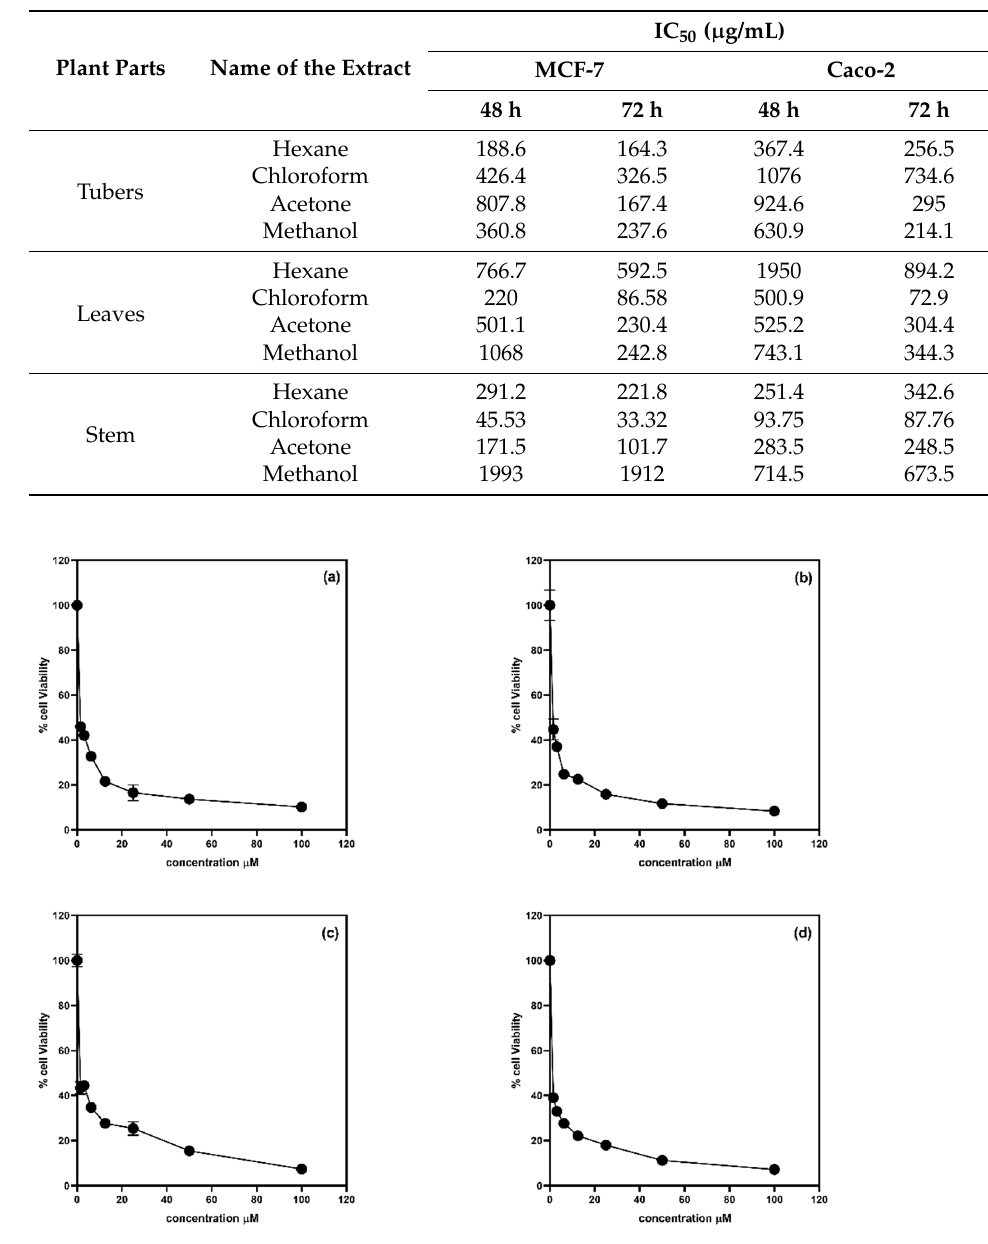
Figure 4. Graphical representation of cell viability percentage of doxorubicin ( a )—on MCF-7 for 48 h incubation; ( b )—on MCF-7 for 72 h incubation; ( c )—on Caco-2 for 48 h incubation; ( d )—on MCF-7 for 72 h incubation. Values are expressed as mean ± SD of three experiments ( p -value relative to control group: p < 0.05).